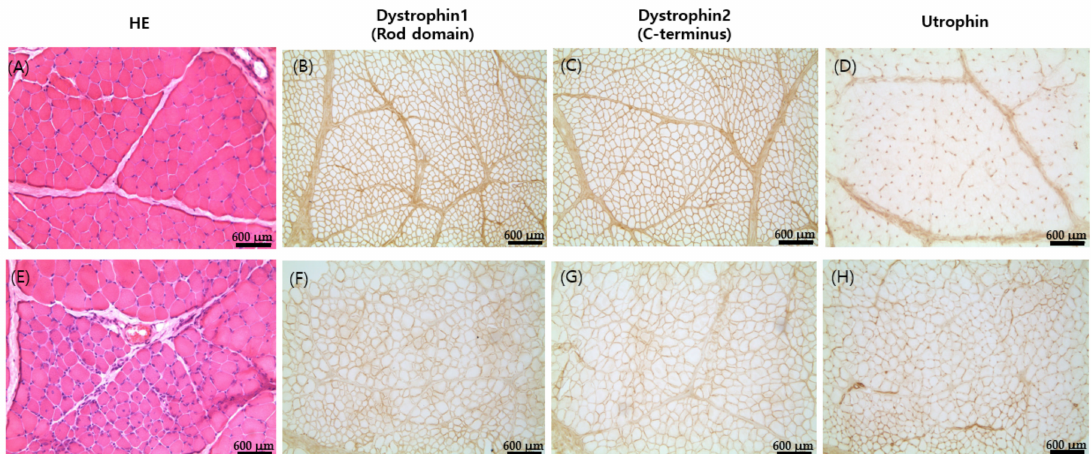
Figure 3. Histopathological analyses of dystrophic muscle in control ( A – D ) and dystrophin mutant dog ( E – H ). Muscle pathology showing focal necrosis and regeneration of muscle fibers (HE); im- munohistochemical staining using monoclonal antibody against dystrophin rod domain and utrophin showing decreases in dystrophin 1 and dystrophin 2 expression and increased utrophin expression compared to control muscles (scale bar = 600 µ m).